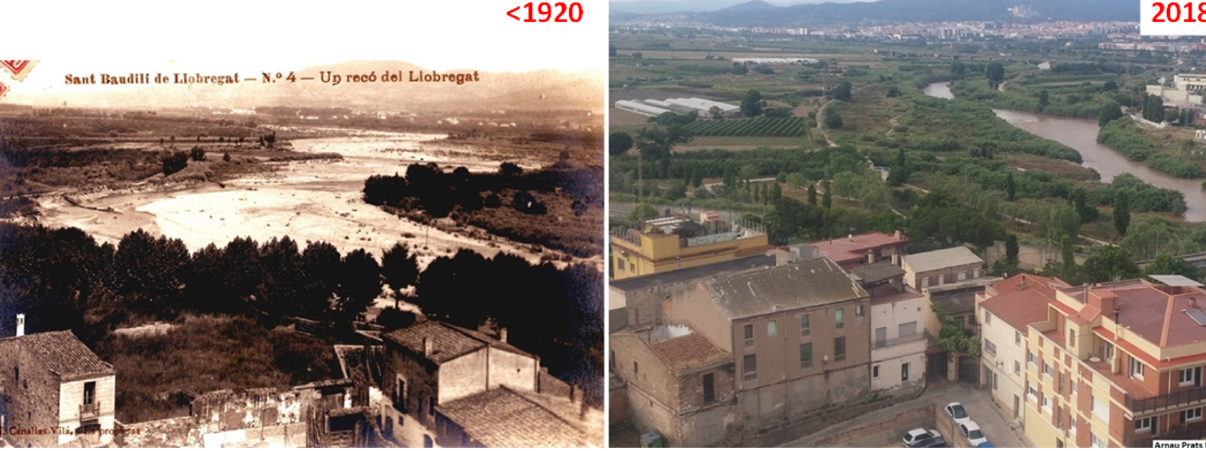
Figure 7. Pictures of the Llobregat looking upstream prior to 1920 (left, anonymous in Catalan National Archives) and in 2018 (right, by A. Prats-Puntí) from the same viewpoint on top of the bell tower in town C (Fig.